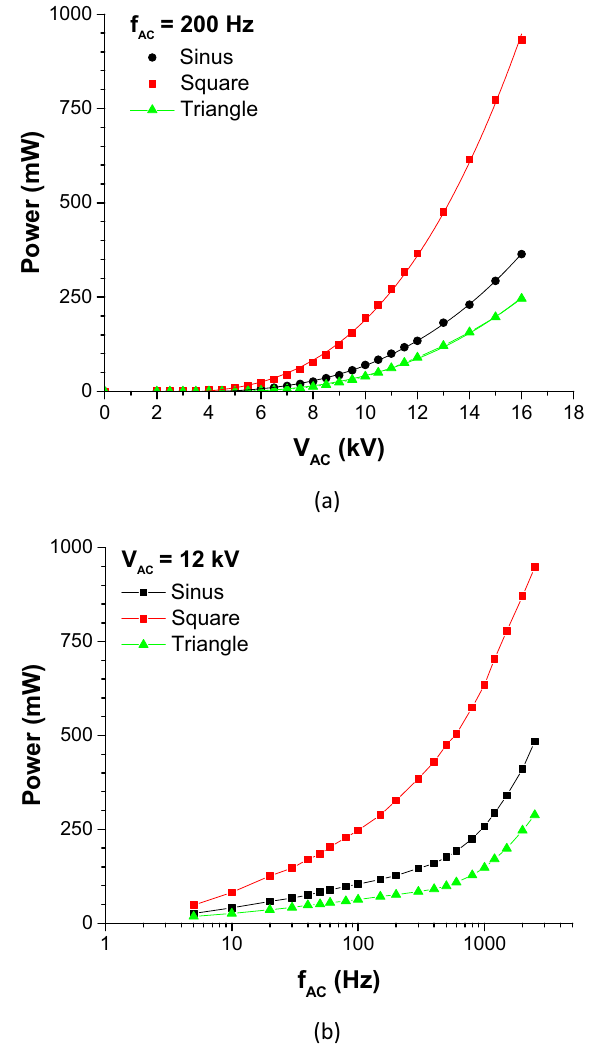
Figure 2. Electrical power consumption versus voltage amplitude V AC for f AC = 200 Hz ( a ) and electrical power consumption versus frequency f AC for V AC = 12 kV ( b